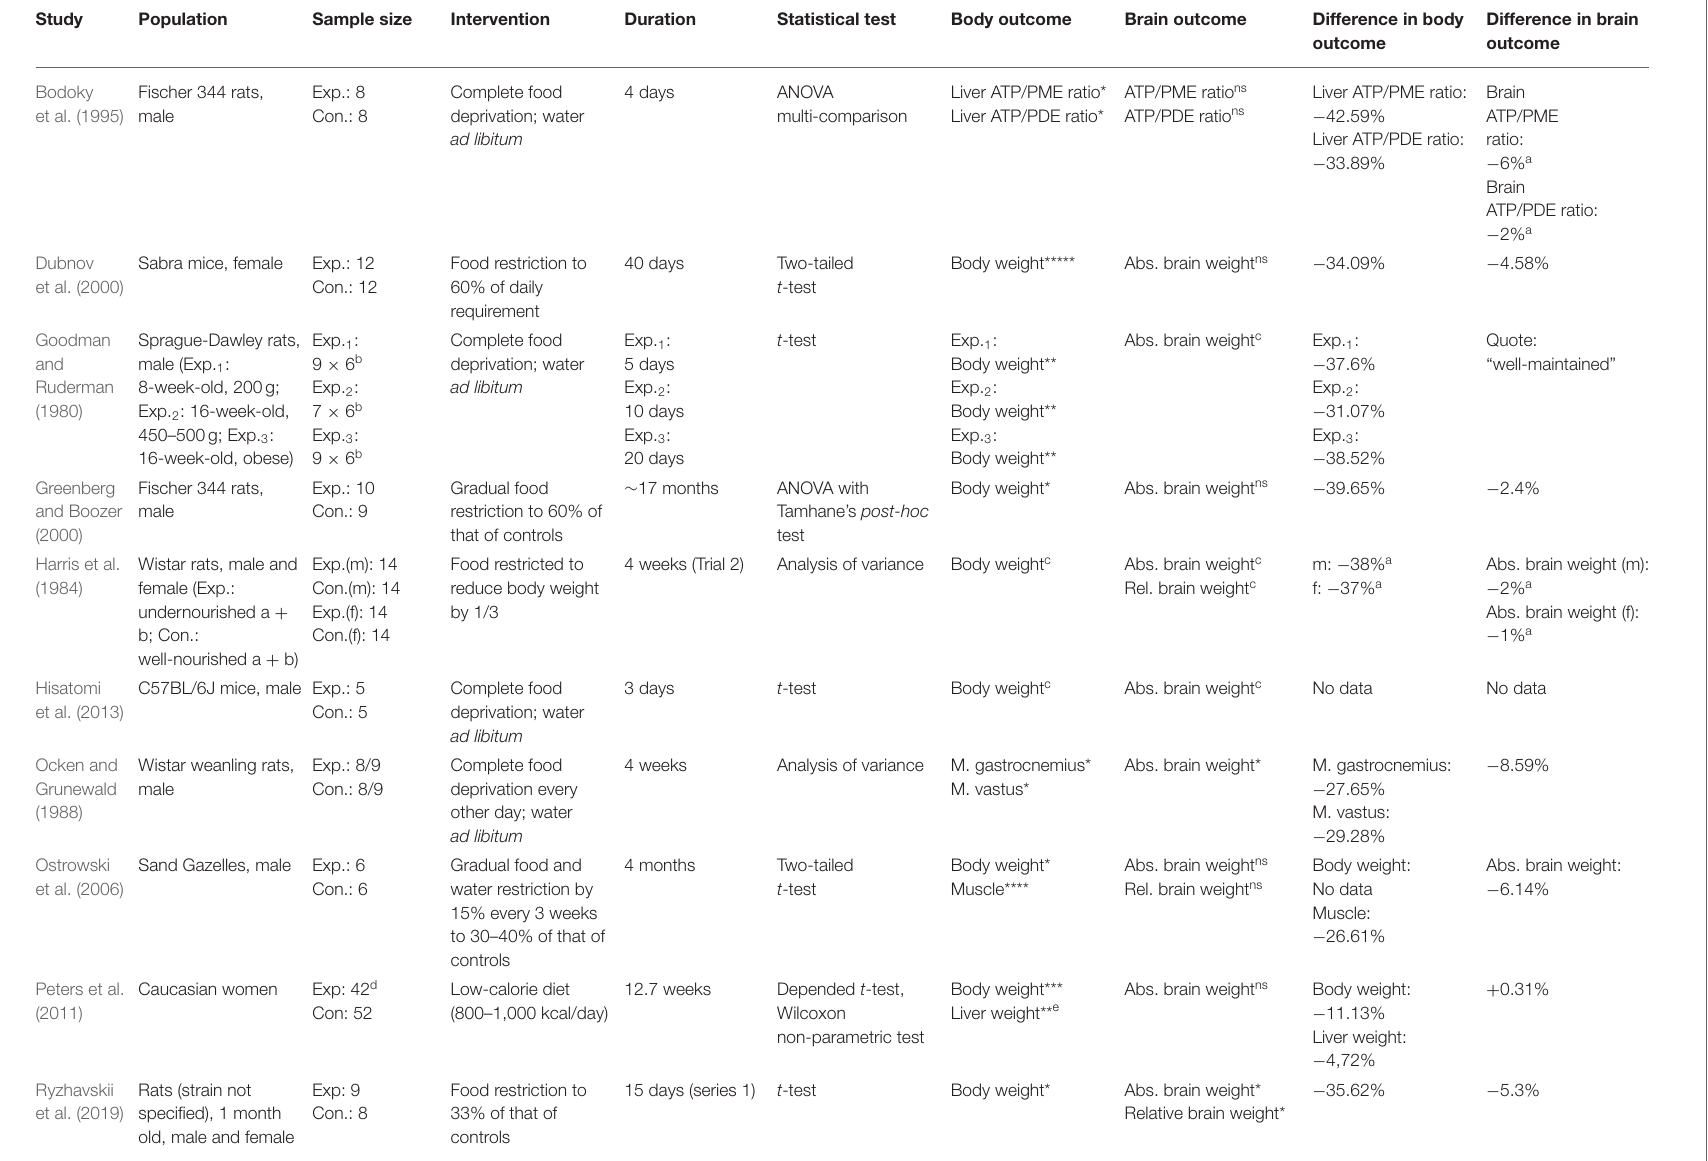
TABLE 1 | Characteristics and results of included studies.